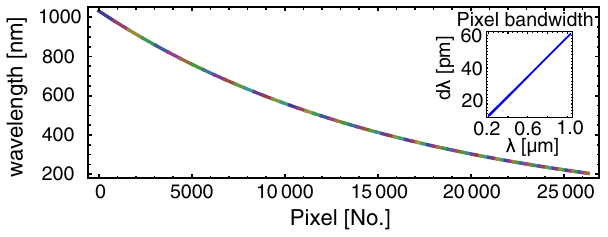
FIG. 10. Wavelength calibration fit for the echelle spectrom- eter: Each color-distinguished partition of the curve represents a diffraction order. The inset here and in the following figures shows the spectral bandwidth covered by individual pixels as a function of wavelength.